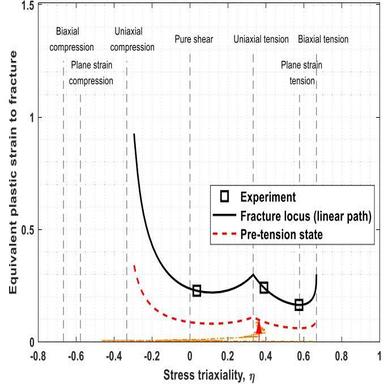
Pre-tension test for ductility decrease.